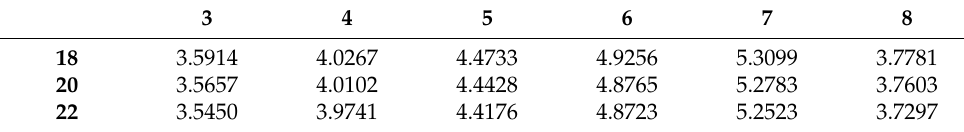
Table 8. The ef f ( j , k ) value of the Symlets family (wavelet length